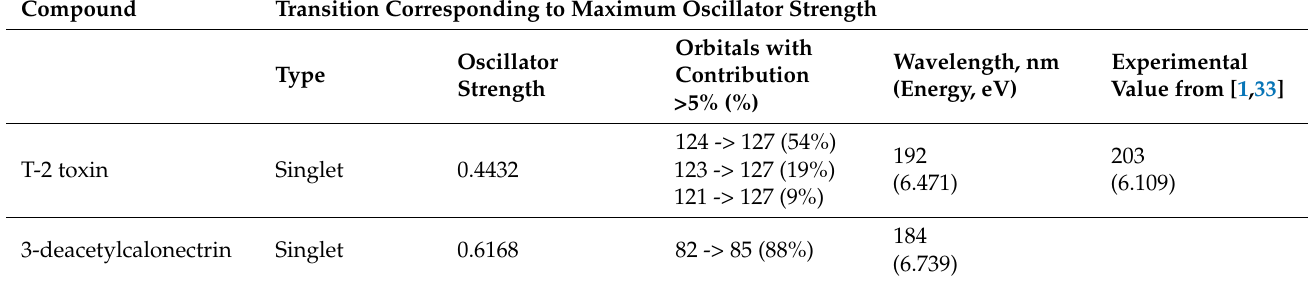
Table 3. Comparison of theoretical and experimental results for UV absorbance